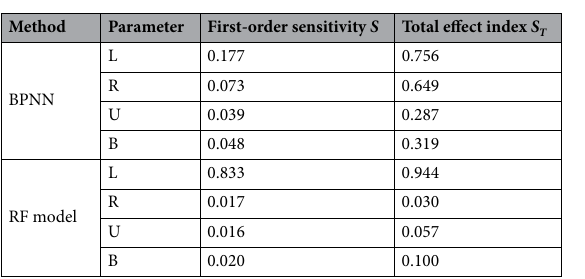
Figure 18. Experimental versus predicted tunnel floor settlement for the BPNN and RF model on data set.